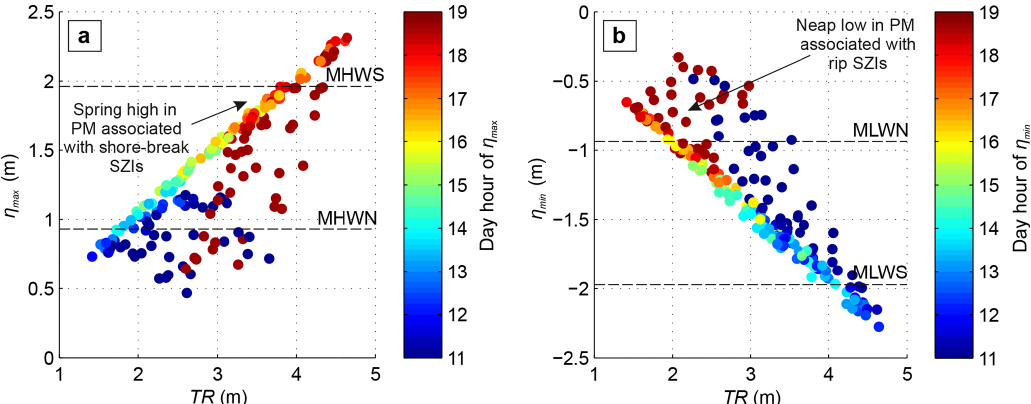
Figure 12. (a) Daily maximum tide elevation, η max , during lifeguard-patrolled hours versus daily TR with a colour bar indicating the hour of η max occurrence; (b) daily minimum tide elevation, η min , during lifeguard-patrolled hours versus daily TR with a colour bar indicating the hour of η min occurrence.